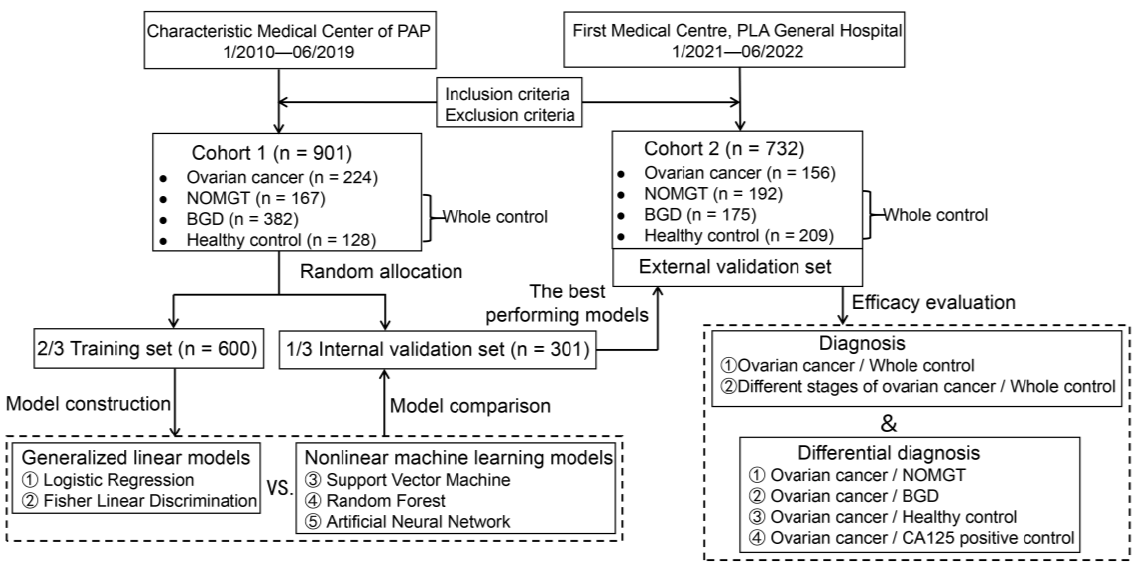
Figure 1. Flow chart of cases enrolled and model construction. NOMGT, non-ovarian malignant gynecological tumor; BGD, benign gynecological disease